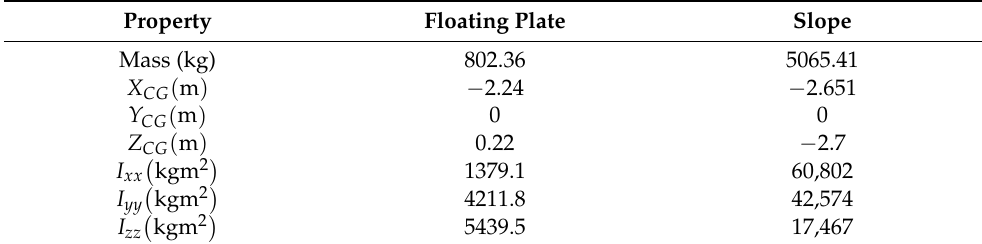
Table 1. S-PWEC components parameters.